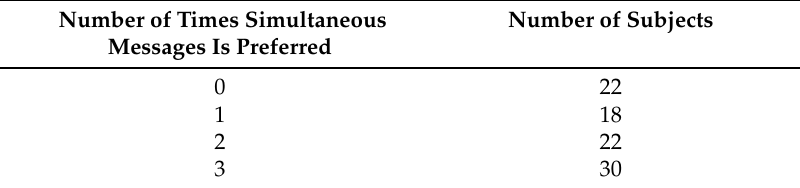
Table 6. Receiver Behavior in the Choice Treatment.